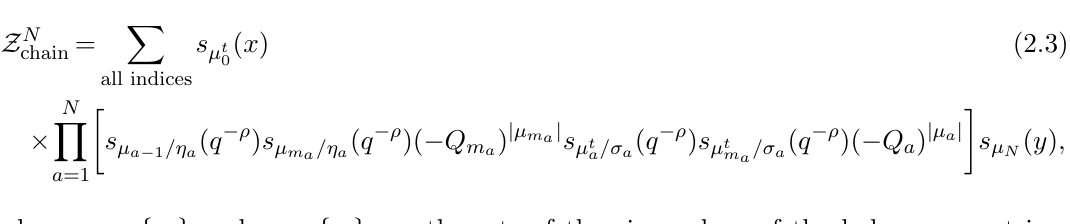
Figure 2 . The N -chain geometries with the branes denoted by the red lines. The variables Q m and Q i denote the K(cid:127)ahler parameters along the slanting and horizontal lines. z = f z g is the set of the eigenvalues of the holonomy matrix M , we i